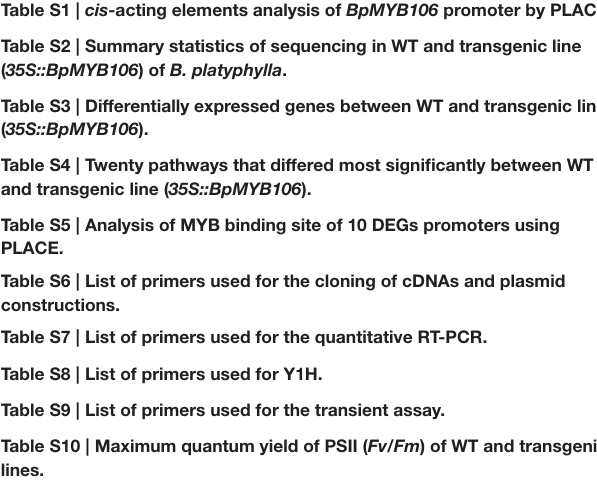
Figure S1 | Nucleotide and amino acid sequence of BpMYB106 . Gray sections indicate conserved domain of R2R3-MYB DNA binding sites. Figure S2 | Multiple-sequence alignment of R2R3-MYB proteins from different model plant species. A conserved motif of the R2R3 domain is boxed with black lines. Figure S3 | Nucleotide sequence of BpMYB106 promoter. Lined section indicates BpMYB106 gene sequence contained initiation site “ATG.” Figure S4 | Regeneration and identification of BpMYB106 transgenic lines. (A,B) Leaf and stem explants. Red arrows indicated the transgenic callus sites. (C) Transgenic cluster of shoots has formed from leaf callus. (D) Transgenic callus formed on one of the cut sites in a stem segment. (E) A transgenic cluster of shoots cultured in differential medium for 15 days. (F) Transgenic shoots transferred to rooting medium. Figure S5 | Stomatal density investigation in WT and transgenic lines ( 35S::BpMYB106 ). (A) Stomatal density of leaf abaxial surface in WT and transgenic lines of line 1, line 3, line 8, and line 9. The black bar indicated the length of 100 µ m. (B) Quantity statistics of stoma between WT and transgenic lines. Error bars on each symbol indicate the mean ± SE of three replicate reactions. Figure S6 | GO functional classification of differentially expressed genes (DEGs). Table S1 | cis -acting elements analysis of BpMYB106 promoter by PLACE.